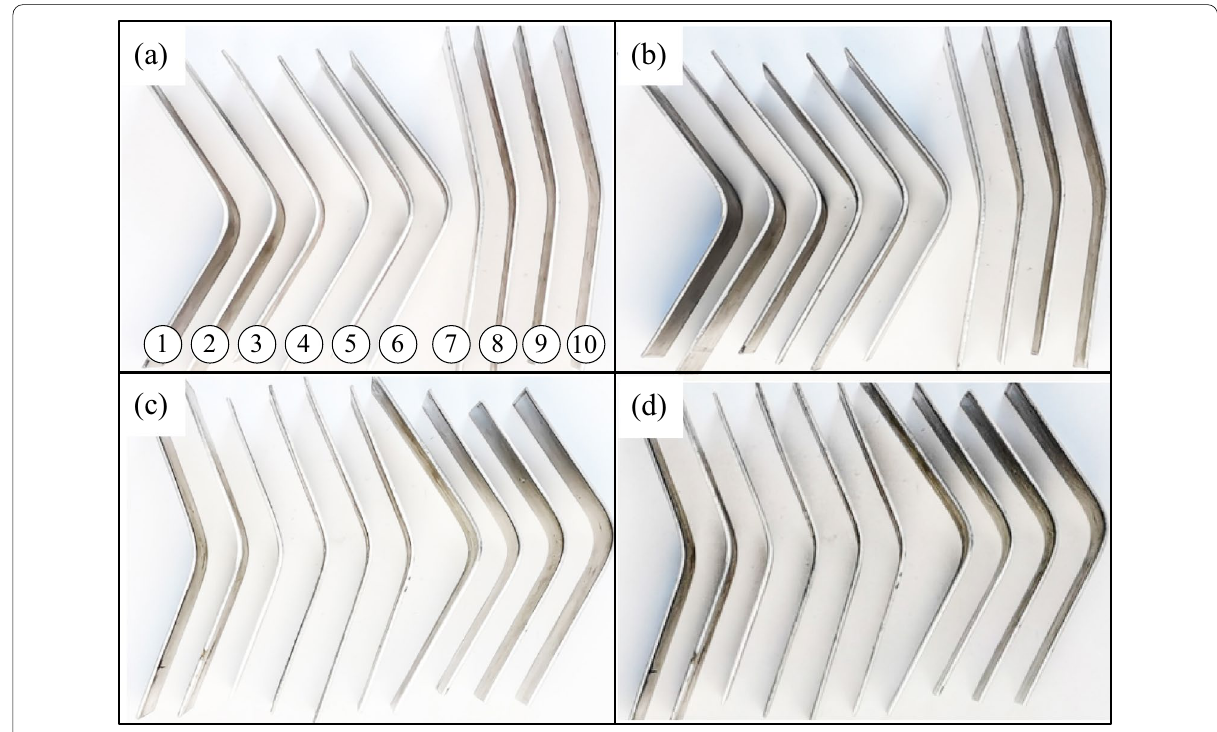
Figure 22 SUS304 bending parts after springback: a G1-60-20, b G2-60-20, c G3-40-60, d